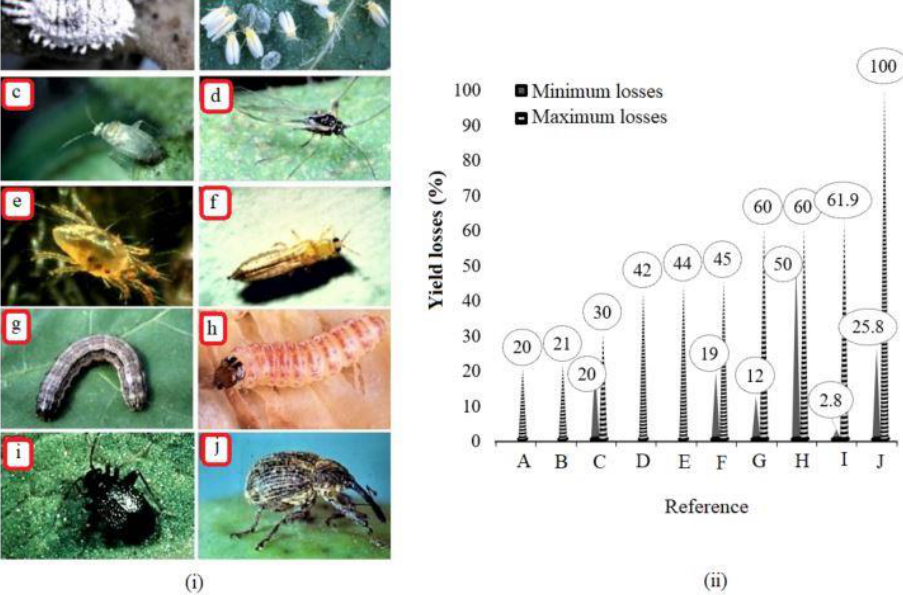
Figure 5. Serious pests in cotton fields ( i ) and corresponding yield lost per pest category ( ii ). In ( i ),